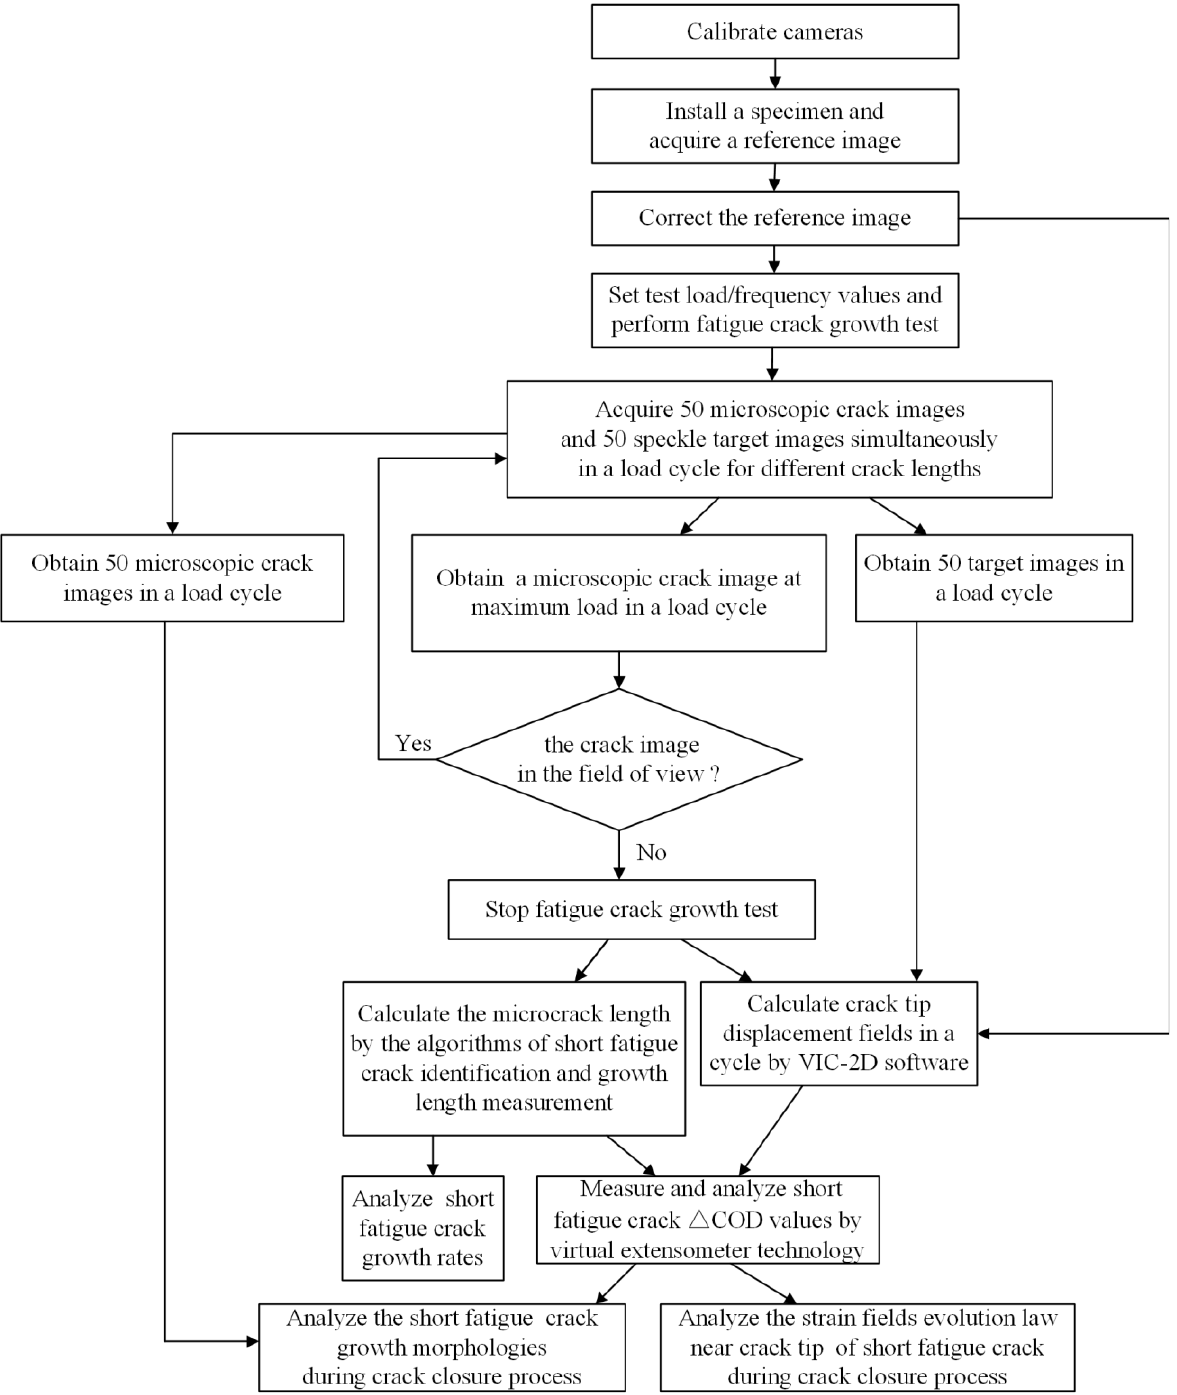
Figure 1. Overview of the proposed method.